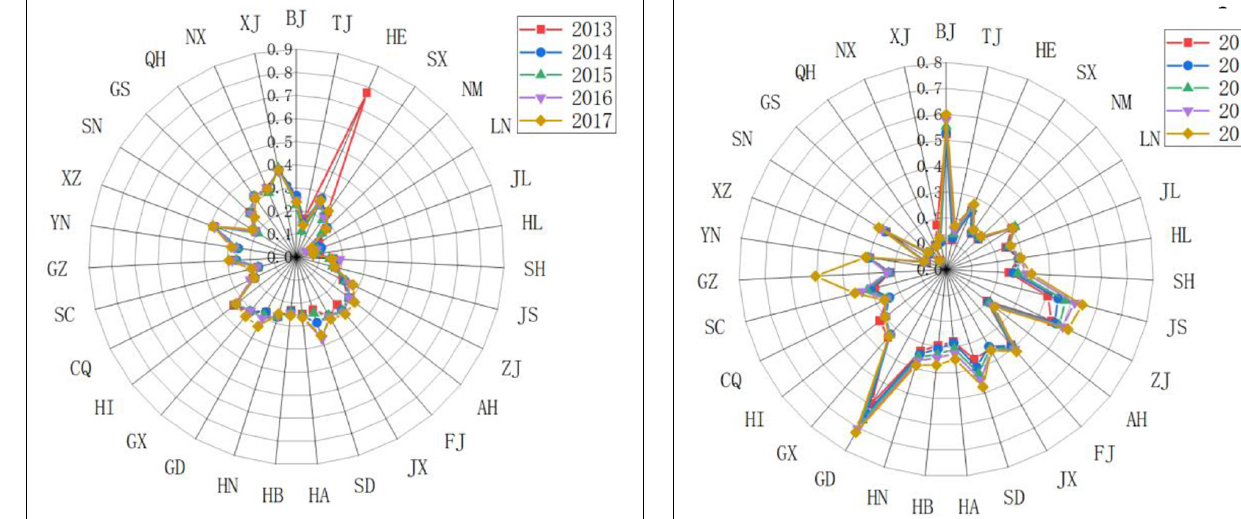
As shown in Figures 7 , 8 , Zhejiang, Guangdong, Jiangsu, Hubei, and Shaanxi have achieved better governance